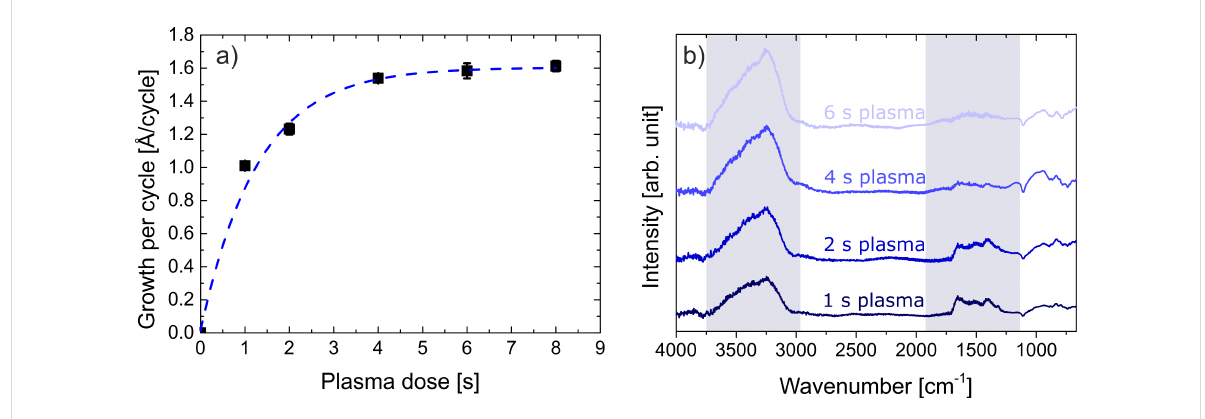
Figure 1: a) Growth per cycle (GPC) as a function of the plasma dose time. The saturation of the PE-ALD ZnO recipe was reached at 6 s of plasma exposure. Error bars are plotted for all data points but are within marker size for most points. b) FTIR spectra of the zincone-like layers deposited at different plasma pulse time. The spectra are offset for clarity. The main absorption regions attributed to the ν OH (3000–3600 cm − 1 ) and to the stretching of carbonate/bidentate/carboxyl groups ( ν OCO ) (1300–1660 cm − 1 ) are highlighted in the